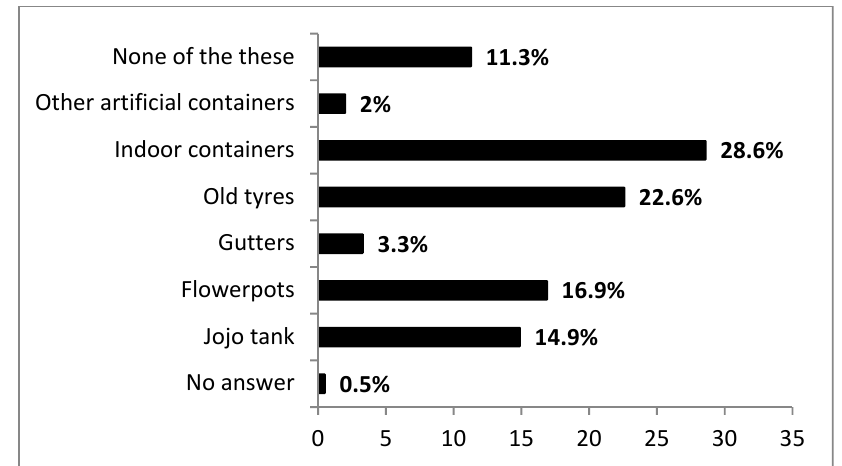
Figure 2. Details of the structure and diversity of water holding containers (outlined by respondents), that may serve as potential mosquito breeding sites found on the premises of respondents across sub-districts.